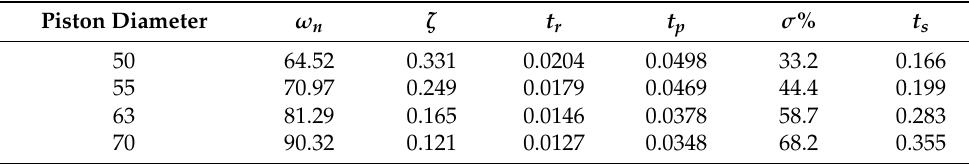
Table 2. Dynamic indicators of various model parameters.